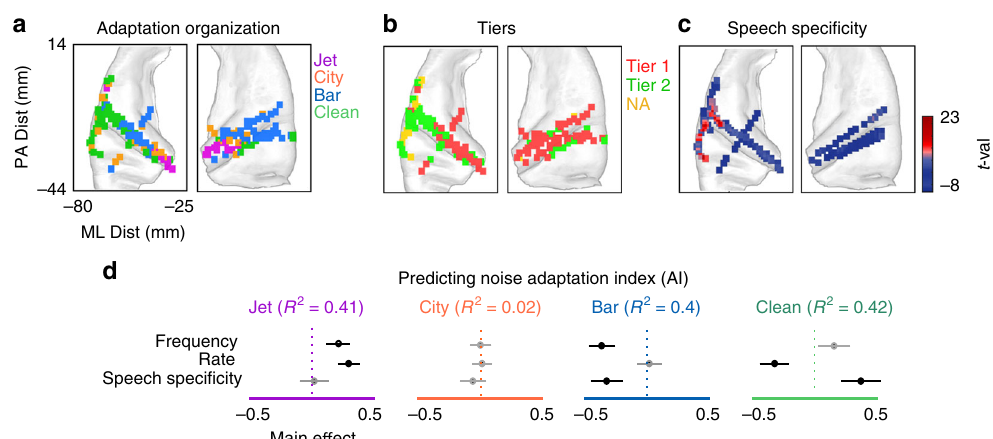
Fig. 7 Spatial organization of adaptation patterns. a Anatomical organization of electrodes with the largest adaptation to each background condition on the left and right brain hemispheres. b Anatomical organization of the top two clusters and nonadaptive electrodes. c Anatomical organization of speech speci fi city based on t -values of an unpaired t -test between neural responses to speech and nonspeech sound categories. d R-squared values for predicting the adaptation indices from electrodes ’ best frequency, best rate (temporal modulation), and speech speci fi city. The contribution (main effect) of each parameter in predicting the adaptation indices is also shown ( t -test, black: p < 0.01, gray: p >